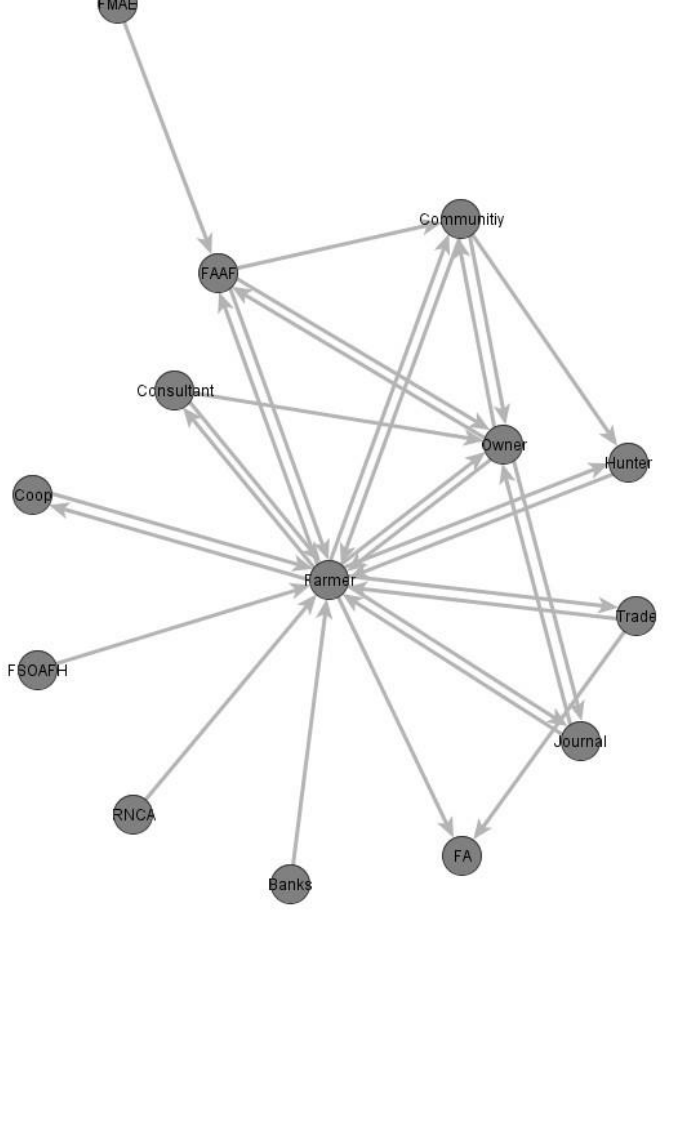
Figure A3.3. Local network when four and more links between actors were